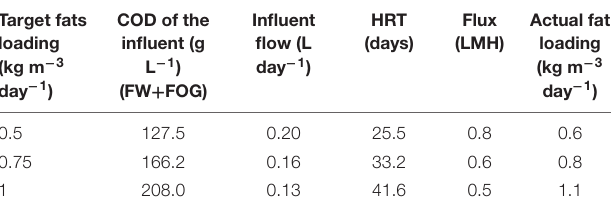
TABLE 2 | The operating conditions of the TP-MP reactor at different fat loading